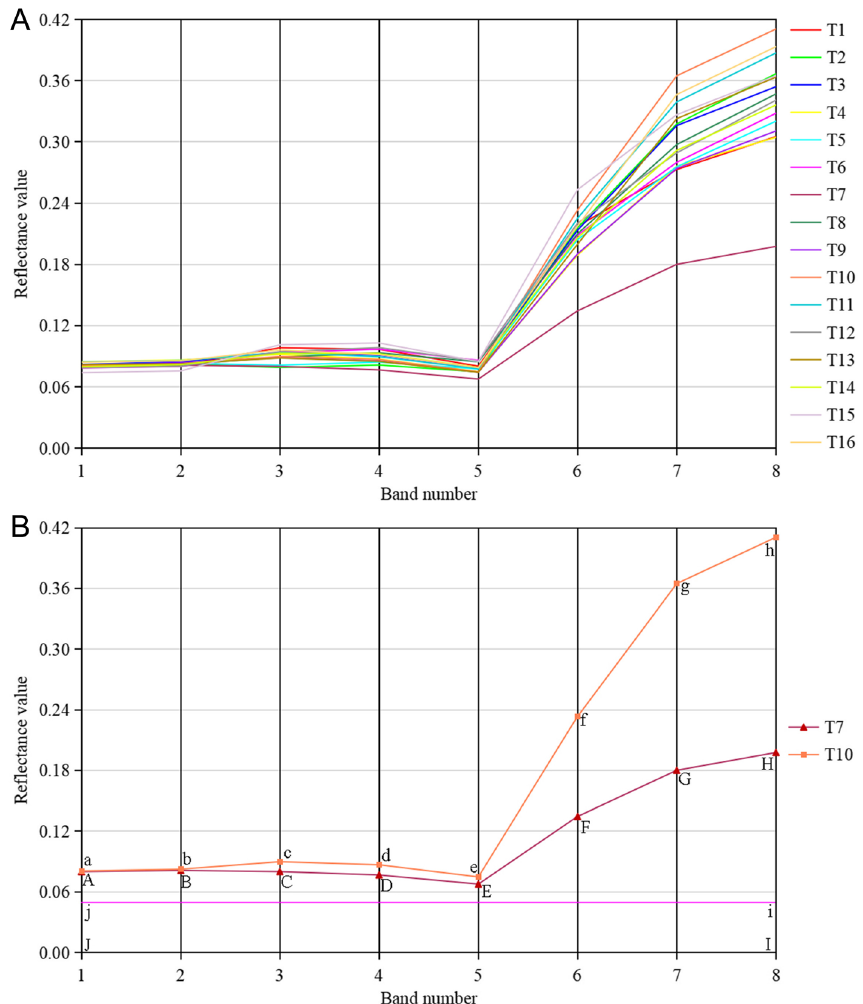
Fig. 2 Polygons with different area sizes formed by spectral curves of different tree species/bamboo. A Average reflectance spectral curves of the various tree species/bamboo in WorldView-3. Differences are found in the polygonal area sizes of various tree species/bamboo, and these polygons are formed by the spectral curves and the horizontal and vertical axes. B Creation process of polygon area index and relative area constraint described by the graphic illustration. The tree species T7 and T10 were taken with the largest difference in the polygon area in A as an illustration